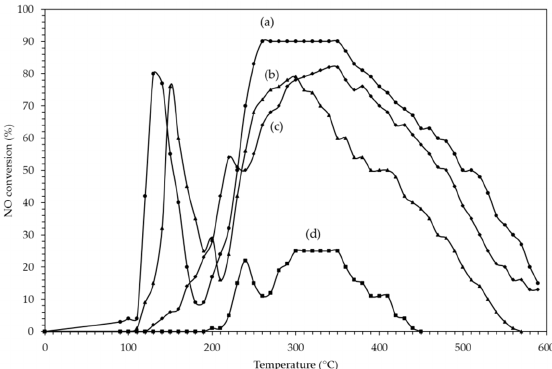
Figure 9. Bimetallic catalyst of PtAg for the C 3 H 8 –SCR–NO: ( a ) 0.1PtAg / AW; ( b ) 0.25PtAg / AW; ( c ) 0.4PtAg / AW; ( d ) 1PtAg / AW in the presence of H 2 . Inlet gas composition: 500 ppm NO, 625 ppm C 3 H 8 , 200 ppm CO, 660 ppm H 2 , 2 wt% O 2 , N 2 balance; GHSV = 128,000 h − 1 .